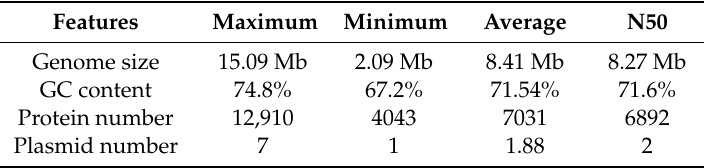
Table 1. Genomic information of Streptomyces